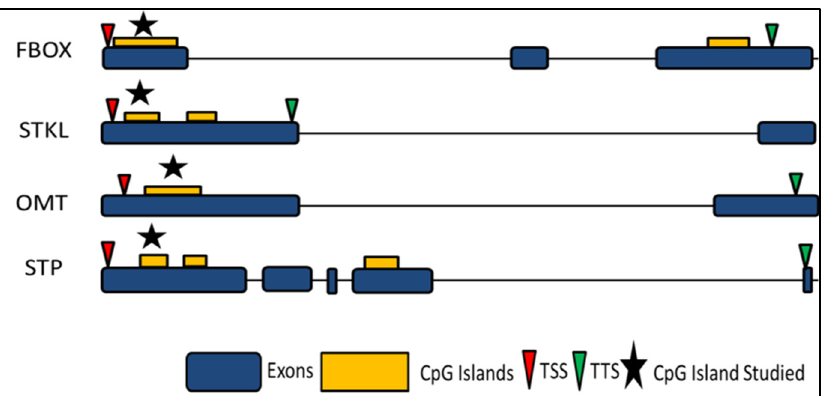
Figure 9. Gene structure prediction of loci namely, F-box protein PP2-B15 (FBOX), STOREKEEPER protein-like (STKL), Probable O methyltransferase 3 (OMT) and serine/threonine-protein phosphatase 7 long form homolog (STP). Blue and yellow boxes represent the exons and CpG Island, respectively. Red and green arrows indicate Transcription Start Site (TSS) and Transcription Termination Sites (TTS). Stared CpG Island has been used for methylation dependent restriction digestion and qPCR.